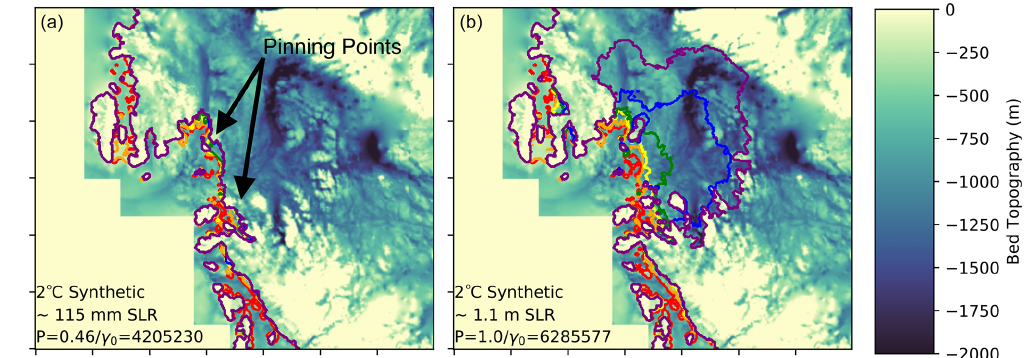
Figure 14. Grounding line location evolution over the 2 ◦ C synthetic run for (a) p = 0 . 46 /γ 0 = 4205230 and (b) p = 1 . 0 /γ 0 = 6285577. Red, orange, yellow, green, blue and purple contours indicate years 0 to 525 at roughly 100-year intervals. Shaded background shows seafloor topography (m). Negative values indicate below sea level. Note that the ice in this area is largely grounded below sea level. Table 5. Combinations of p and γ 0 used in the subset of extended simulations. Extended